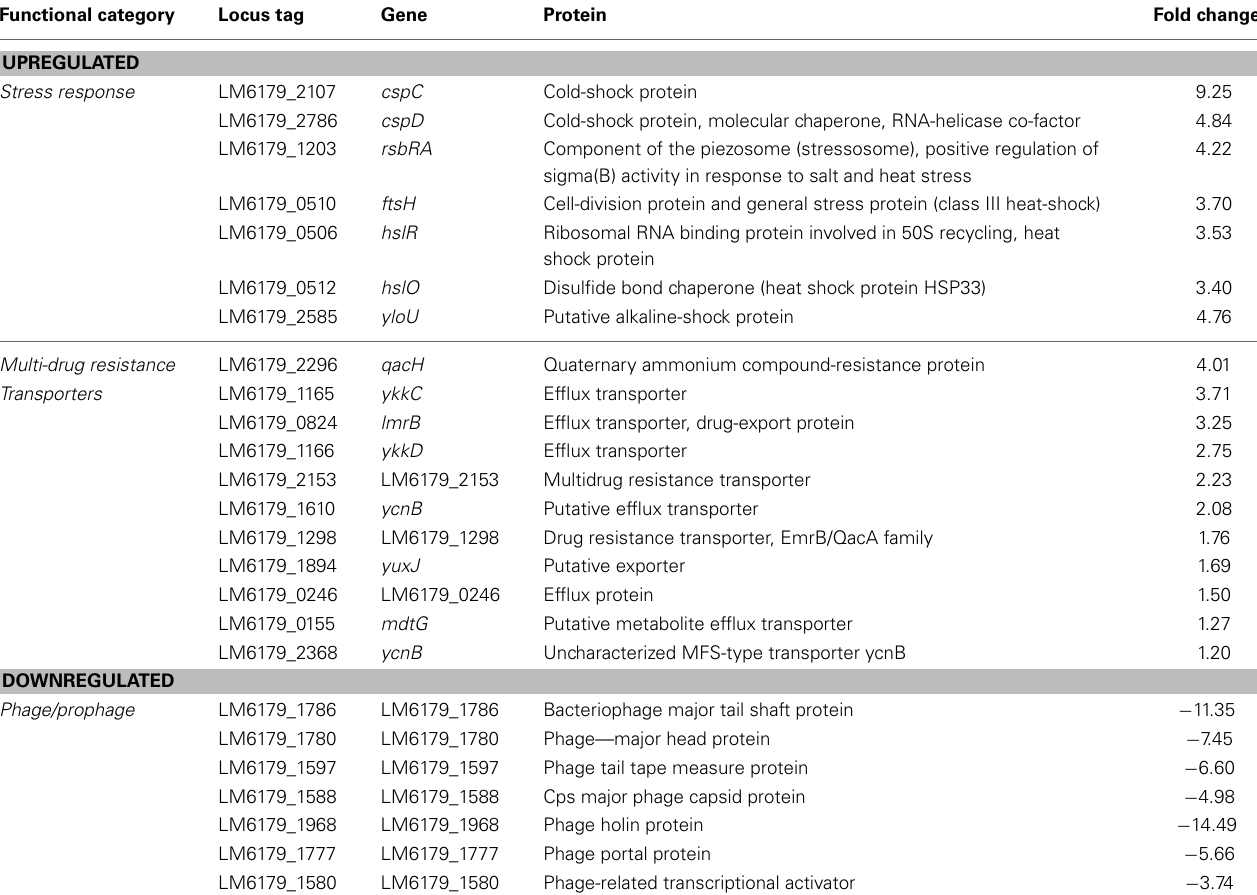
Table 7 | Stress response, multi-drug resistance transporter, and phage/prophage genes which change in regulation following exposure of strain 6179 to